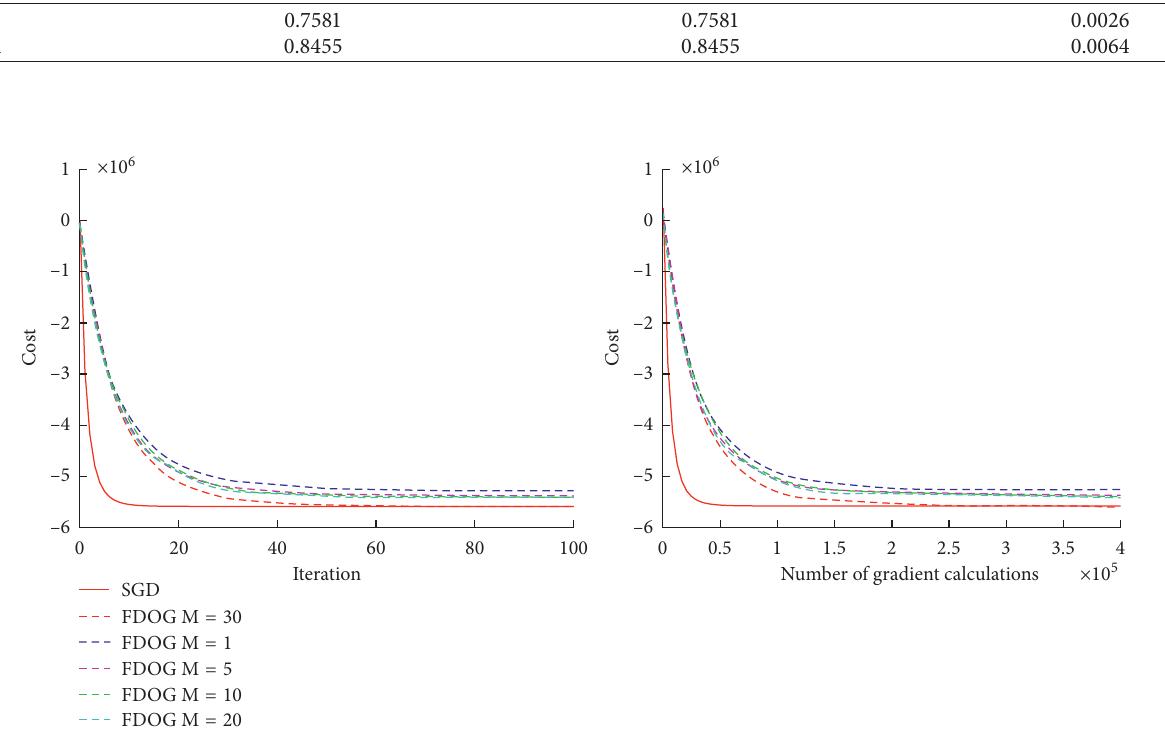
Figure 5: The convergence behavior with different M .